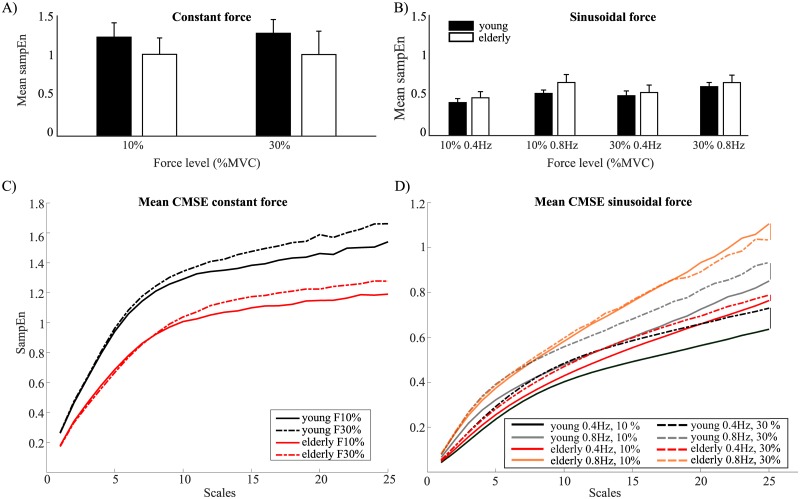
Multiscale entropy of produced force.Mean sample entropy for (A) constant and (B) modulation tasks, for young (black) and elderly participants (white) for 10% and 30% maximum voluntary contraction (MVC) and at 0.4 and 0.8 Hz. Error bars represent the standard deviation. The mean composite multiscale entropy curves for young (black) and elderly (red) at (C) constant forces of 10% MVC (filled line) and 30% MVC (dotted line). The mean composite multiscale entropy curves for young (black and grey) and elderly (red and orange) at (D) sinusoidal forces at 10% MVC (filled line) at 0.4 and 0.8 Hz and at 30% MVC (dotted lines).